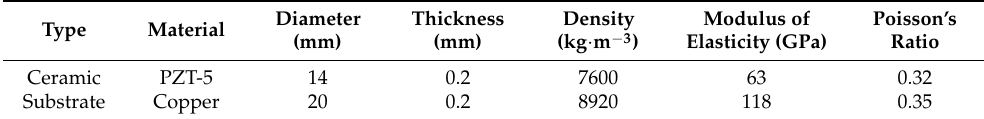
Table 1. Related parameters of the piezoelectric